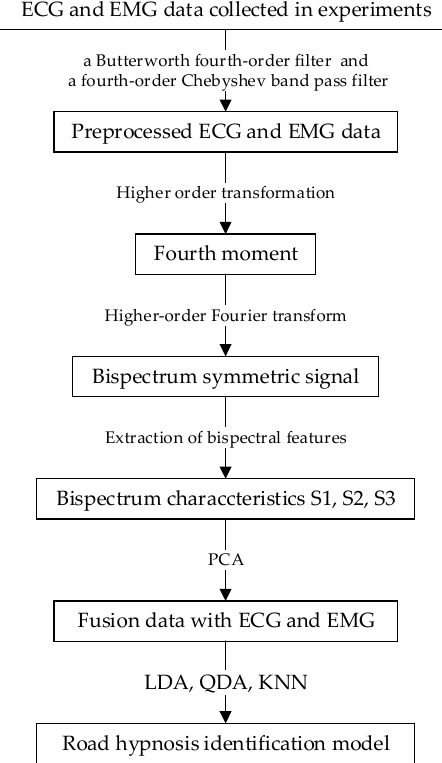
Figure 4. Process of establishing the road hypnosis identi fi cation model.